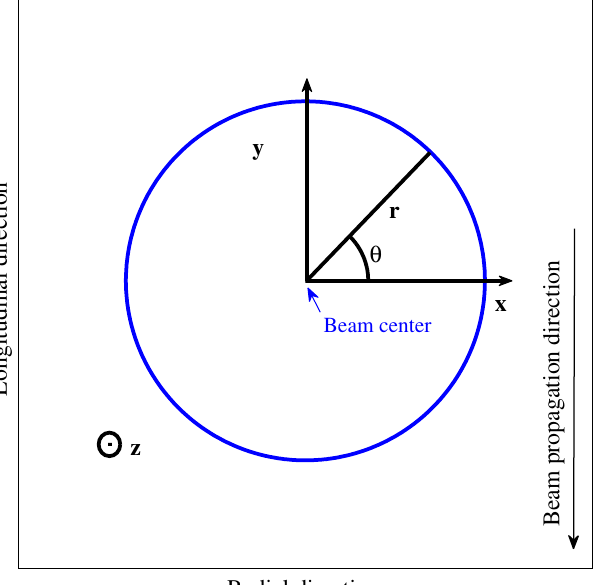
FIG. 2. ð x; y Þ and ð r; (cid:1) Þ coordinate systems used for the nu- merical simulations and the physical interpretation of